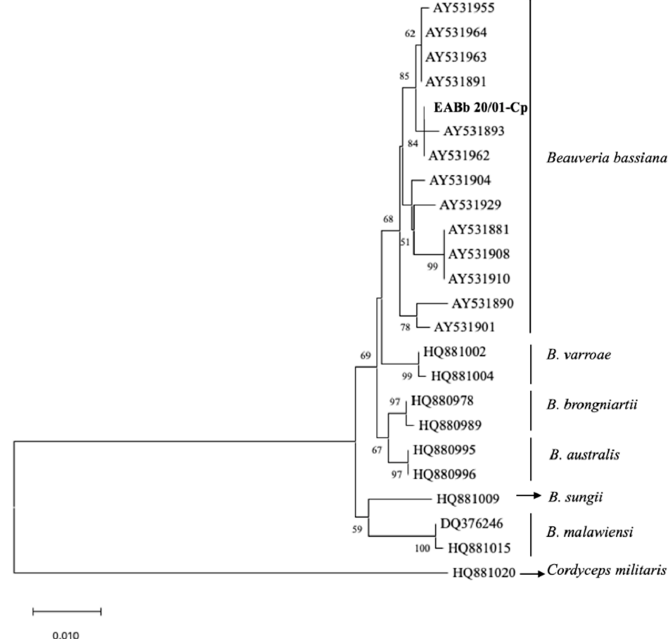
Figure 1. Phylogenetic tree of the EF1- α sequence from the Beauveria bassiana EABb 20/01-Cp (in bold) strain and 23 reference strains based on the neighbor-joining method using the Tamura 3-parameter method, with an outgroup and 1000 replicates of bootstrapping. A support threshold of 50% was set. 3.3. Efficacy of Beauveria bassiana in Controlling Cydalima Perspectalis Larvae The survival probability of the larvae of the different instars treated with B. bassiana